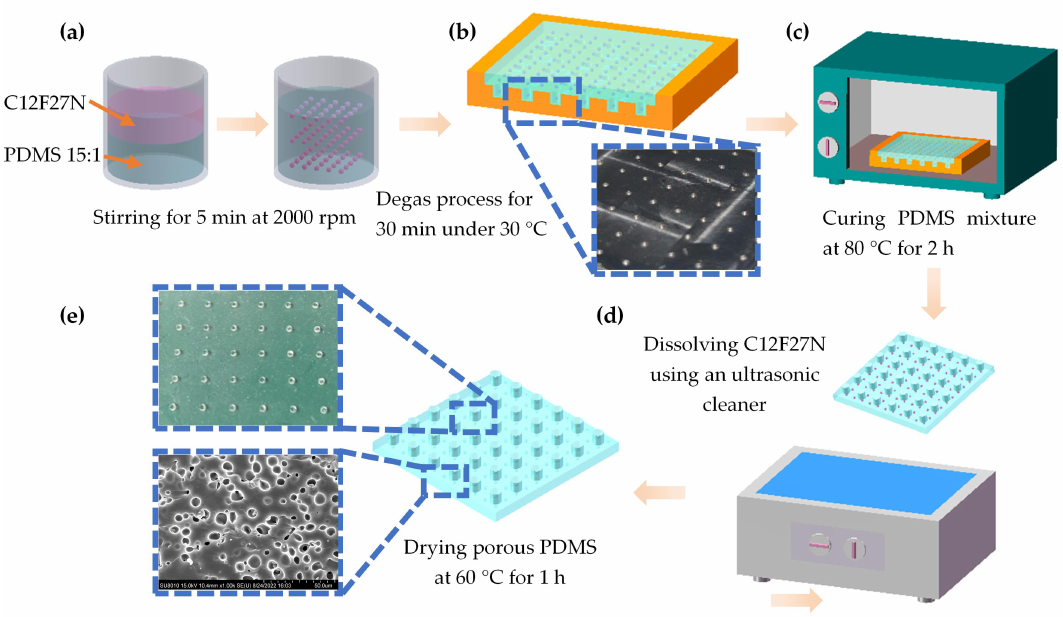
Figure 2. Schematic illustration of the fabrication process of porous PDMS dielectric layer: ( a ) Prepa- ration of PDMS-C12F27N emulsion; ( b ) Molding and degassing process; ( c ) Curing of the PDMS mixture; ( d ) Dissolving C12F27N; ( e ) Dry